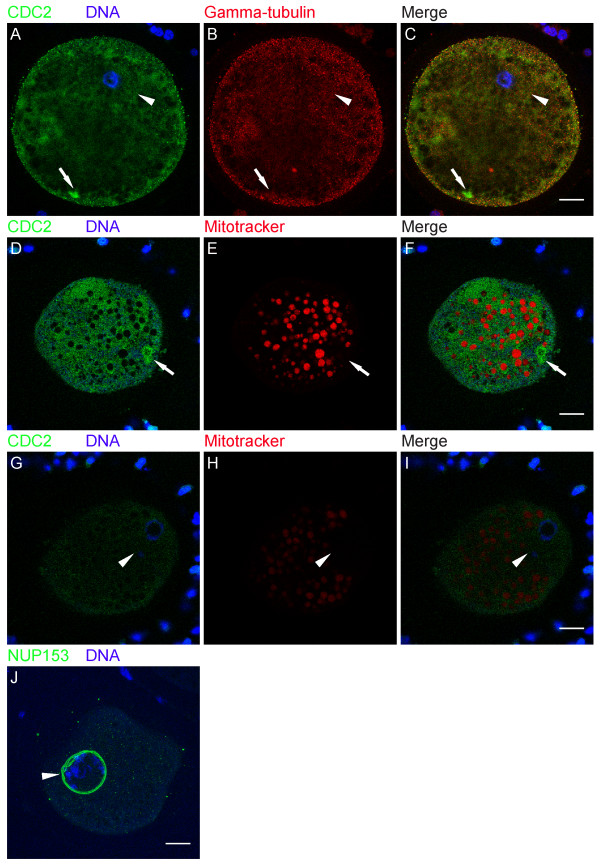
Gamma-tubulin, mitochondria, and NUP153 do not associate with ERES. (A-C) 0 h GV stage oocyte labeled for CDC2 (A, green), DNA (A, blue), and gamma-tubulin (B, red). The CDC2-labeled ERES cluster did not label with gamma-tubulin (C). (D-F) 0 h GV stage oocyte labeled for CDC2 (D, green), DNA (D, blue), and mitochondria, using the mitochondrial marker mitotracker (E, red). Mitotracker did not label CDC2-positive ERES (F). (G-I) Confocal section through the same oocyte as in D-F showing the GV. Note that the much lower staining intensity in G-I compared to D-F is solely the result of a ~65 μm change in depth of imaging, since acquisition settings and image enhancement were identical between these images. (J) 0 h GV stage oocyte labeled for NUP153 (green) and DNA (blue). None of the oocytes examined (0/15) showed a cortical domain. The 3 separate double lines around the GV are the result of small size and shape changes between the 3 consecutive sections used to produce the image. Images are either Z-projections of 3 consecutive sections (A-C, J), or single sections (D-I); scale bars represent 20 μm in C, F, I, and J. Arrows indicate CDC2-labeled ERES, and arrowheads denote the position of the GV.